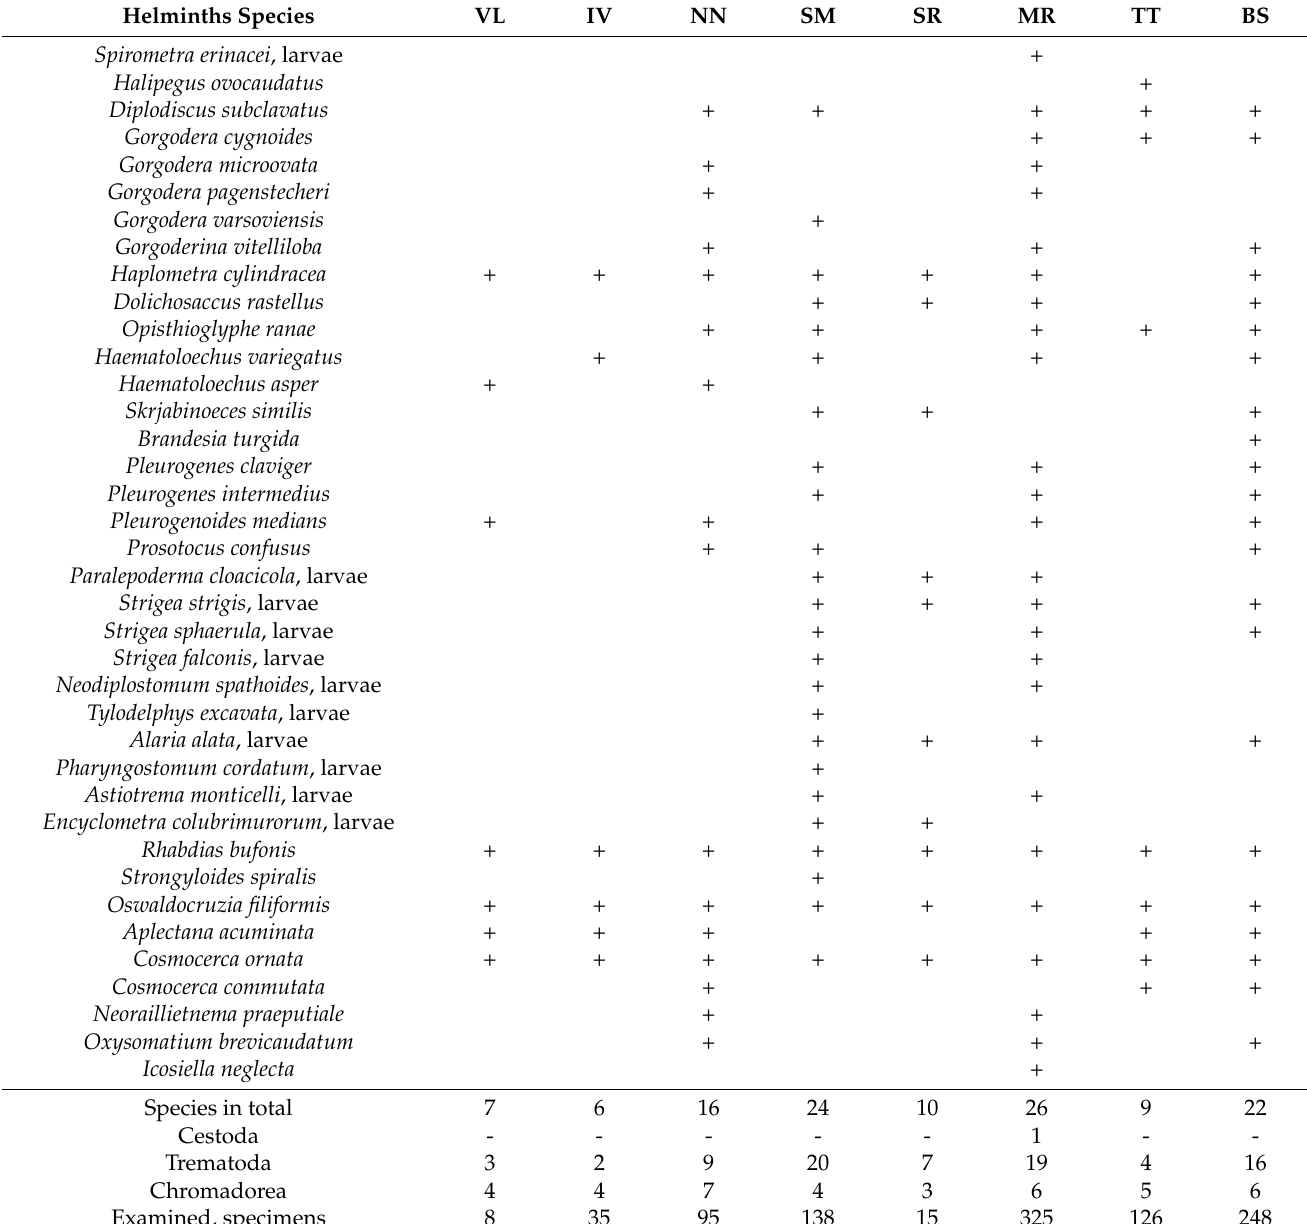
Table 1. Helminths of a moor frog Rana arvalis in the Volga basin